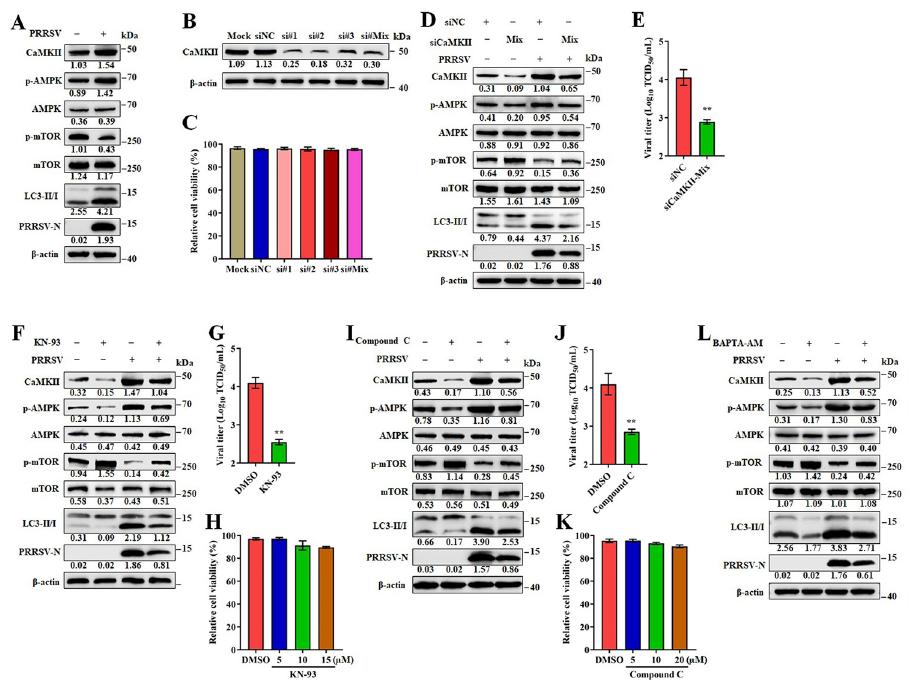
Fig 4. PRRSV induces autophagy through CaMKII-AMPK-mTOR pathway. ( A ) Marc-145 cells were mock or infected with PRRSV (MOI = 0.1) for 24 h. Cell lysates were analyzed by western blotting for CaMKII, p-AMPK, AMPK, p-mTOR, mTOR, LC3-I/II, PRRSV-N, and β -actin. (B-E) CaMKII mediated autophagy is essential for PRRSV efficient replication. ( B ) Western blotting was used to quantitate the level of CaMKII in siRNA1-, siRNA2-, siRNA3-, Mix (the equal amounts of siRNA1, siRNA2 and siRNA3) or siNC-transfected Marc-145 cells. ( C ) The cell viability of Marc-145 cells transfected with in siRNA1, siRNA2, siRNA3 or Mix (the equal amounts of siRNA1, siRNA2 and siRNA3) targeting to CaMKII, or siNC. (D-E) Marc-145 cells were transfected with siRNA Mix (the equal amounts of siRNA1, siRNA2 and siRNA3) targeting to CaMKII or siNC for 24 h, and mock or infected with PRRRV (MOI = 0.1) for another 24 h. ( D ) Cell lysates were prepared and analyzed by immunoblotting using anti-CaMKII, anti-p-AMPK, anti-AMPK, anti-p-mTOR, anti-mTOR, anti-LC3-I/II, anti PRRSV-N, and anti- β -actin antibodies. ( E ) TCID 50 of PRRSV in cell supernatants. (F-H) Marc-145 cells were infected with PRRSV (MOI = 0.1) and treated with KN-93 (10 μ M) or DMSO treatment for 24 h. ( F ) Cell lysates were analyzed by western blotting for CaMKII, p-AMPK, AMPK, p-mTOR, mTOR, LC3-I/II, PRRSV-N, and β -actin. ( G ) TCID 50 of PRRSV in cell supernatants. ( H ) The effect of KN-93 on Marc-145 cell viability. Marc-145 cells were treated with KN-93 at indicated concentrations for 24 h, and then analyzed with CCK-8 system. (I-K) Marc-145 cells were infected with PRRSV (MOI = 0.1) and treated with Compound C (10 μ M) or DMSO for 24 h. ( I ) Cell lysates were analyzed by western blotting for CaMKII, p-AMPK, AMPK, p-mTOR, mTOR, LC3-I/II, PRRSV-N, and β -actin. ( J ) TCID 50 of PRRSV in cell supernatants. ( K ) The effect of Compound C on Marc-145 cell viability. Marc-145 cells were treated with Compound C at indicated concentrations for 24 h, and then analyzed with CCK-8 system. ( L ) Marc-145 cells were infected with PRRSV (MOI = 0.1) with or without BAPTA-AM (30 μ M) for 24 h. Cell lysates were analyzed by western blotting for CaMKII, p-AMPK, AMPK, p-mTOR, mTOR, LC3-I/II, PRRSV-N, and β -actin. The protein levels were quantified by Image J and normalized to β - actin. The data are representative of results from three independent experiments. Error bars indicate the mean ( ± SD) of three independent experiments. * , p < 0.05; ** , p < 0.01; and *** , p <